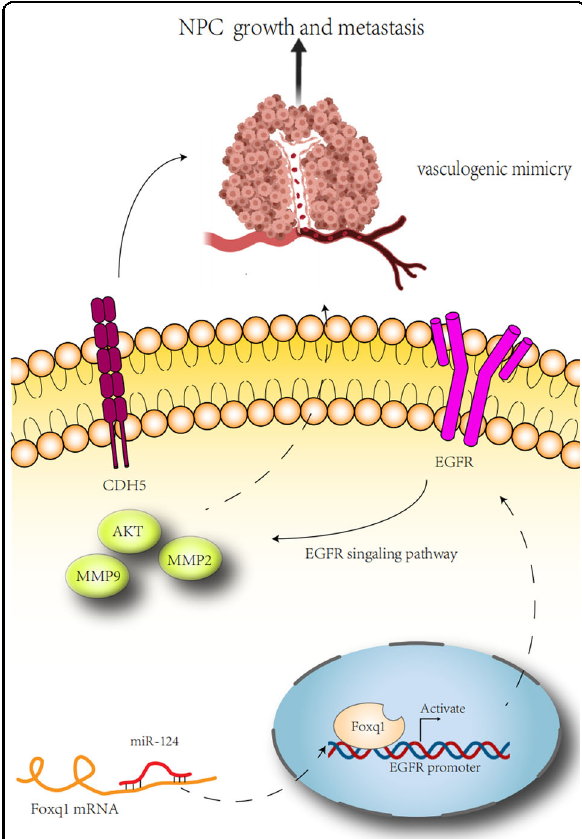
Fig. 8 Schematic diagram of the regulation of VM formation and NPC metastasis by the miR-124/Foxq1 axis. Foxq1, which is the target of miR-124, could directly binds to the EGFR promoter and regulates EGFR transcription, which further promotes NPC growth and metastasis through upregulating EGFR signaling pathway and VM- related